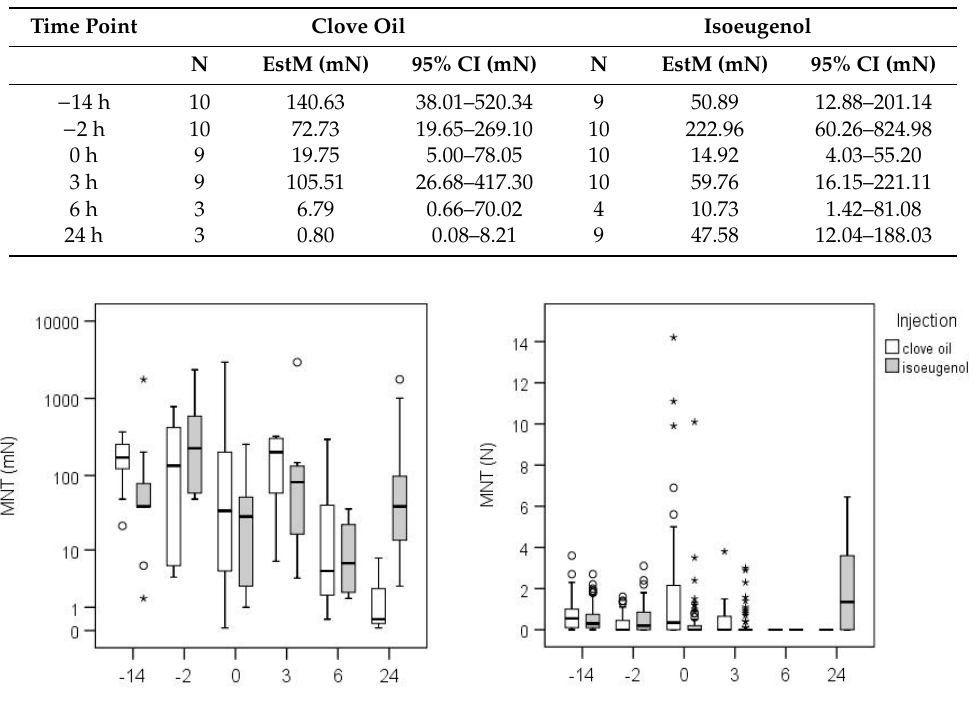
Table 1. Results of the linear mixed model for MNT measured with von Frey filaments in goat kids illustrating the interactions time point*injection ( p = 0.033). Values are back-transformed estimated means (EstM) and lower and upper limit of the 95% confidence interval (CI) of the force applied (in milliNewton) with vFF on the six time points (TP) about 14 h ( − 14 h) and 2 h ( − 2 h) before injection of clove oil or isoeugenol, immediately after injection (0 h) and 3, 6 and 24 h after injection.